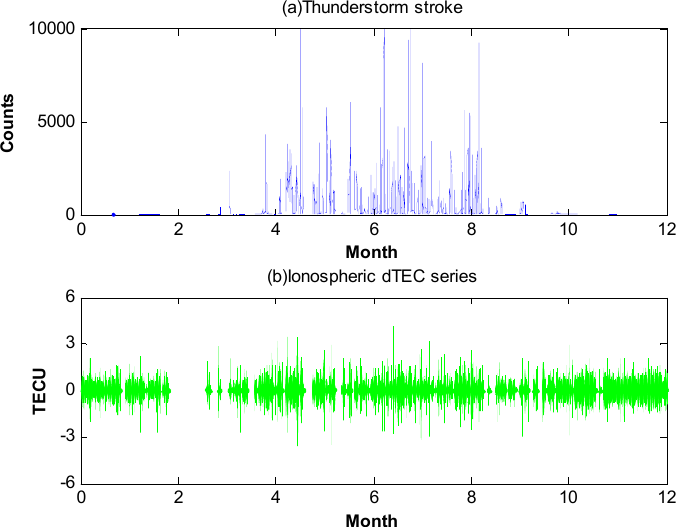
Figure 3. ( a ) Thunderstorm stroke counts recorded by a local lightning network in 2014; ( b ) ionospheric dTEC series observed by the GNSS station, HKKT, in